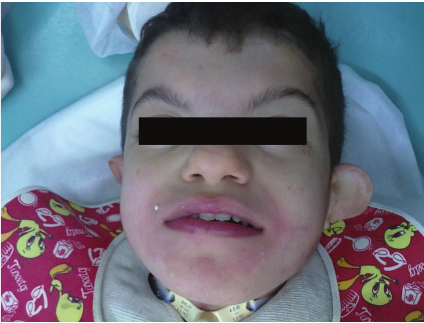
Figure 2: Radiographic examination.